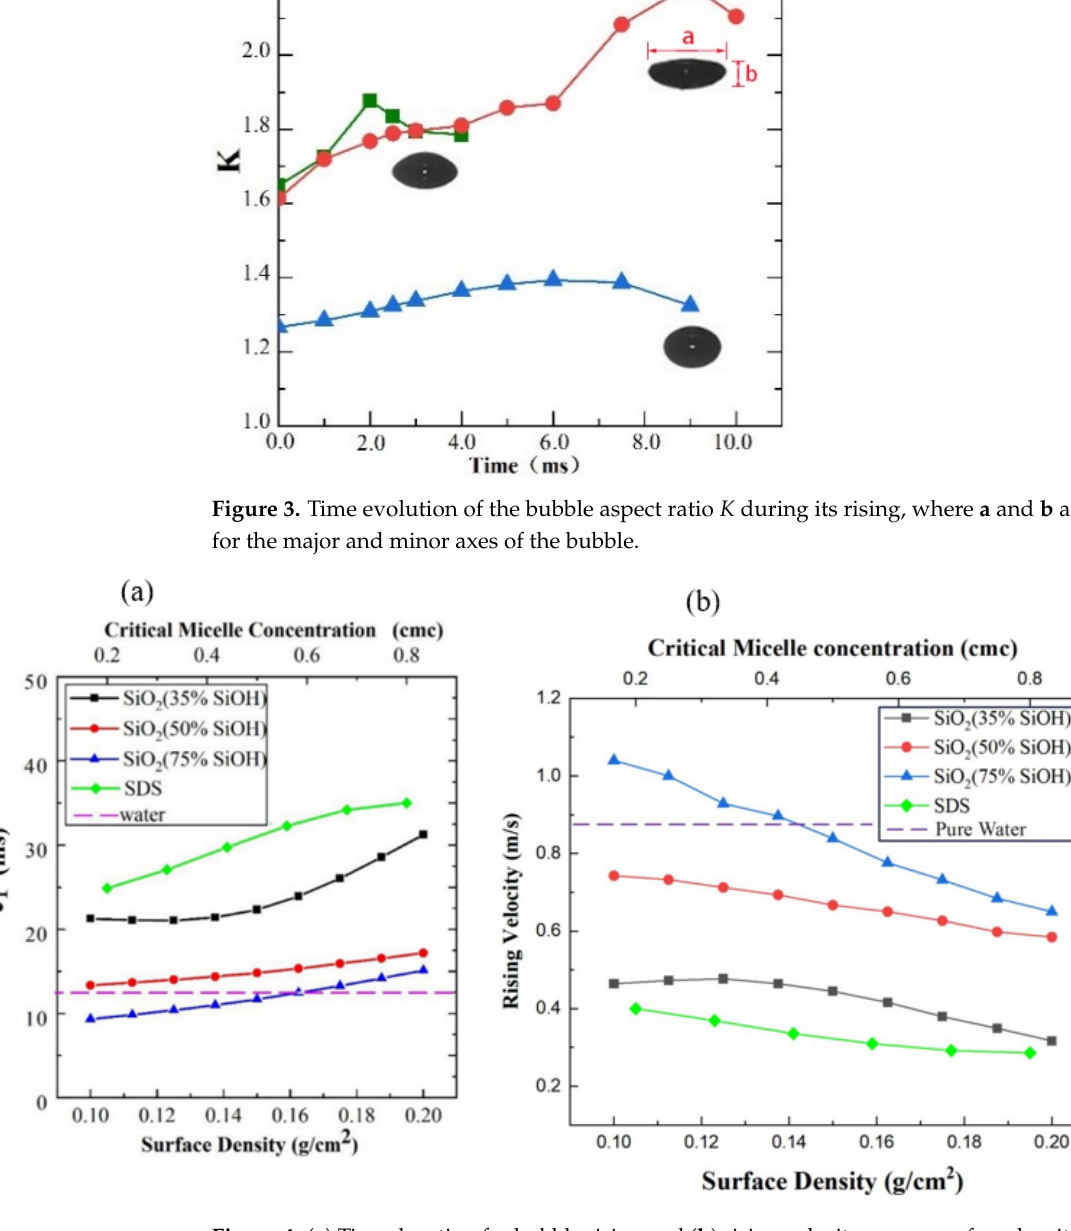
Figure 4. ( a ) Time duration for bubble rising and ( b ) rising velocity versus surface density of particles or SDS concentration.